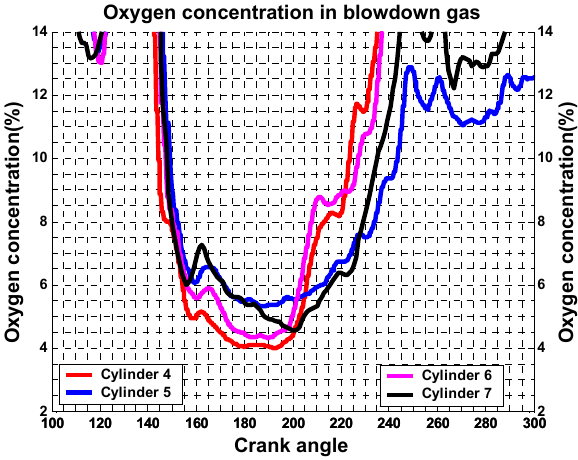
Figure 7. Oxygen concentration in blowdown gas vs. crank angle degrees (aTDC).